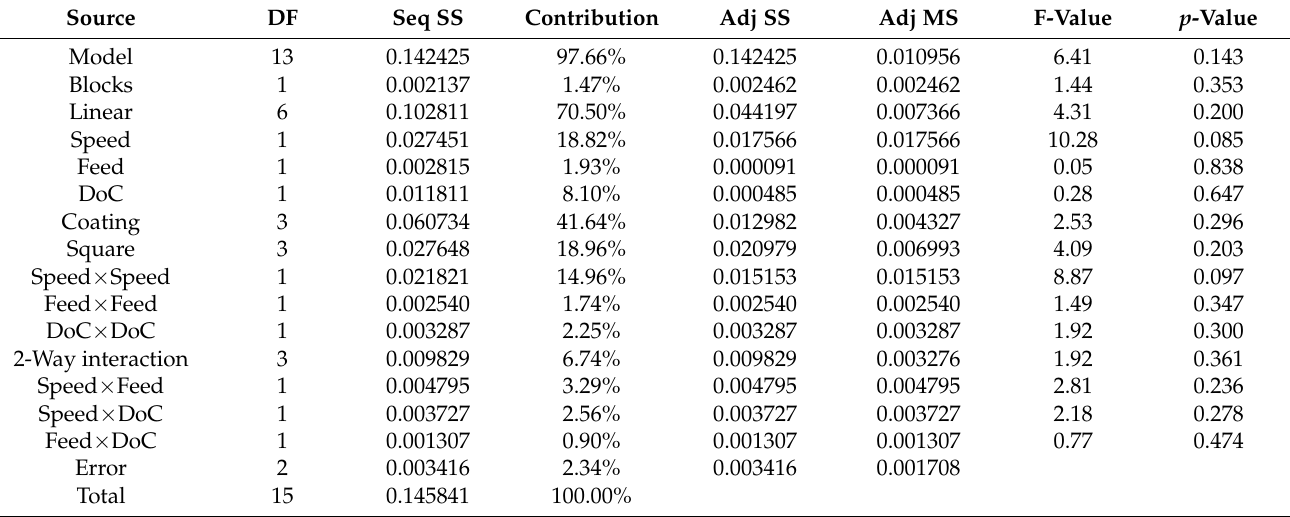
Table 6. Analysis of variance for regression